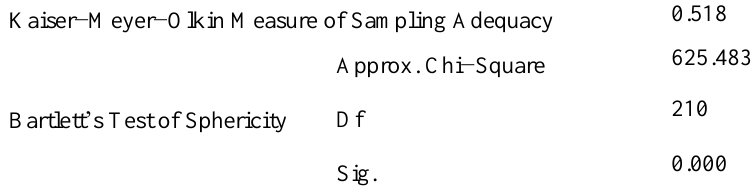
Table 2. KMO and Bartlett’s Test of Sphericity